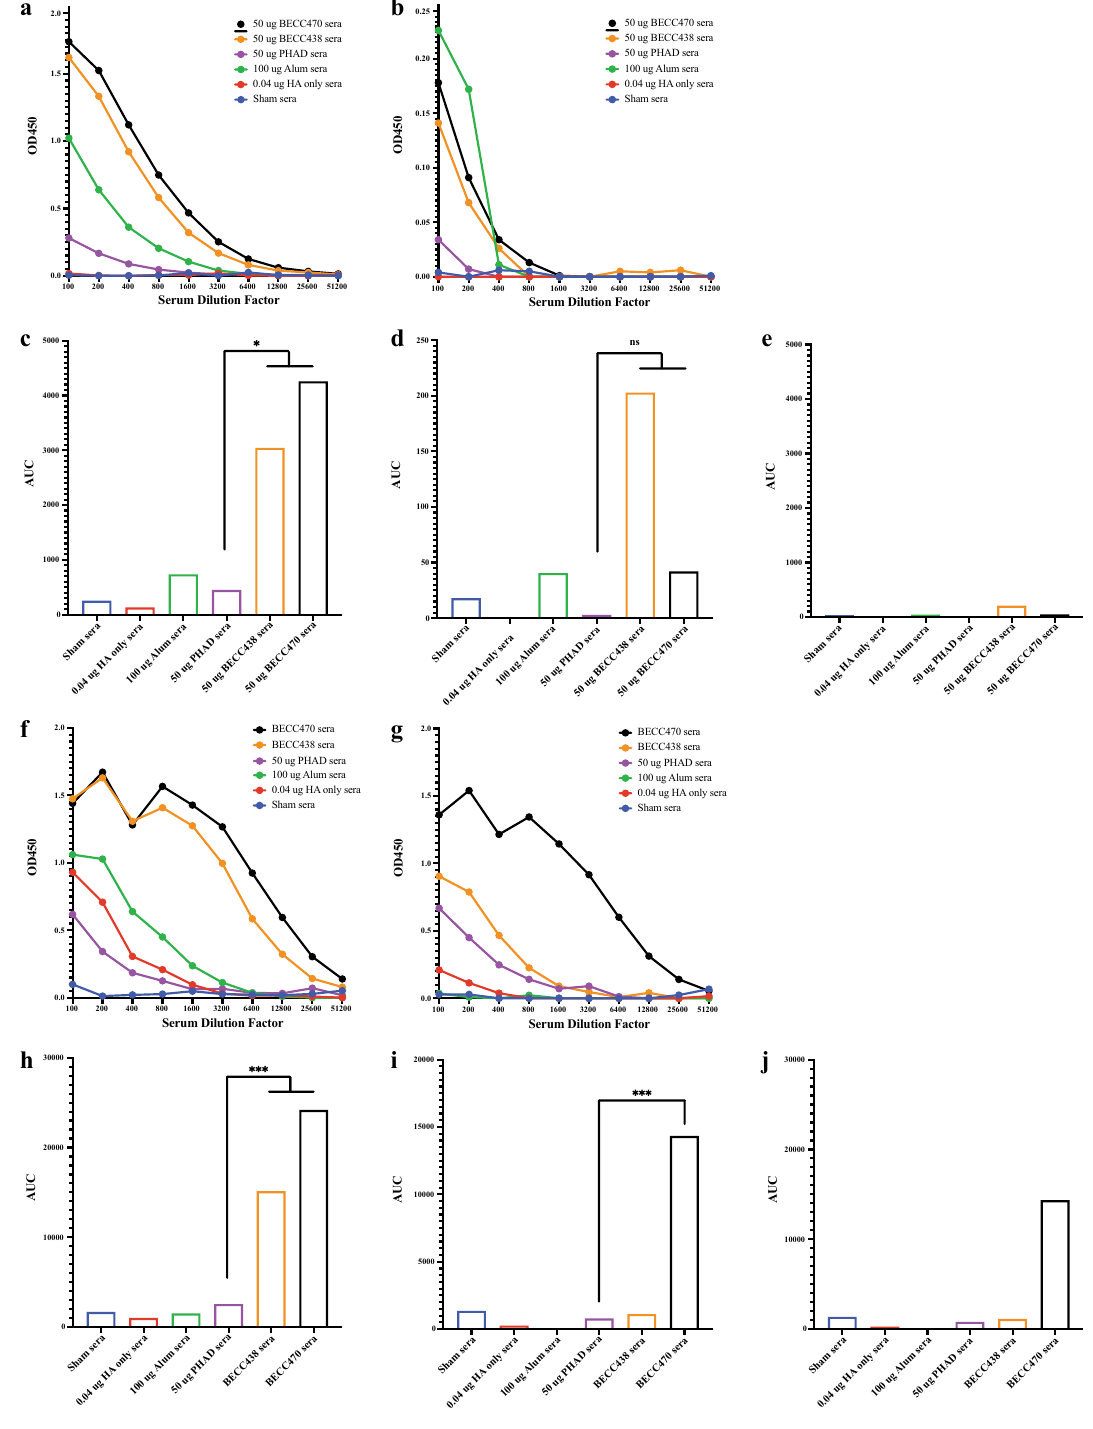
Figure 4. BECC adjuvants increase binding to conserved HA stalk in young but not aged mice. ( a ) ELISA (mean) total IgG binding to stalk-only HA. Pooled sera (by group) from day-28 prime-boost vaccinated young adult BALB/c mice vaccinated with 0.04 µg Cal/09 rHA protein in combination with 100 µg alum, 50 µg PHAD, 50 µg BECC438 or 50 µg BECC470 adjuvant. ( b ) ELISA (mean) total IgG binding to stalk-only HA. Pooled sera from day-28 prime-boost vaccinated aged (12-month-old) BALB/c mice vaccinated with 0.04 µg Cal/09 rHA protein in combination with 100 µg alum, 50 µg PHAD, 50 BECC438 or 50 µg BECC470 adjuvant. ( c ) AUC (mean) of pre-infection total IgG antibody titer curves of young adult mice in figure ( a ) above (BECC438 *p = 0.0208 and BECC470 *p = 0.0136). ( d ) AUC (Mean) of pre-infection total IgG antibody titer curves of aged mice in figure ( b ) above (ns). ( e ) AUC (Mean) of pre-infection total IgG antibody titer in aged mice in ( d ) scaled to young adult mice in ( c ). ( f ) ELISA (mean) total IgG binding to HA1-only HA from young adult BALB/c mice pre-infection day-28 serum. ( g ) ELISA (mean) total IgG binding to HA1-only HA from aged BALB/c mice pre-infection day-28 serum. ( h ) AUC (mean) of pre-infection total IgG antibody titer curves of young adult BALB/c mice in figure ( f ) above (BECC438 ***p = 0.0008 and BECC470 ***p = 0.0002). ( i ) AUC (mean) of pre-infection total IgG antibody titer curves of aged mice in figure ( g ) above (***p = 0.0005). ( j ) AUC (mean) of pre-infection total IgG antibody titer in aged mice in ( h ) scaled to adult mice in ( i